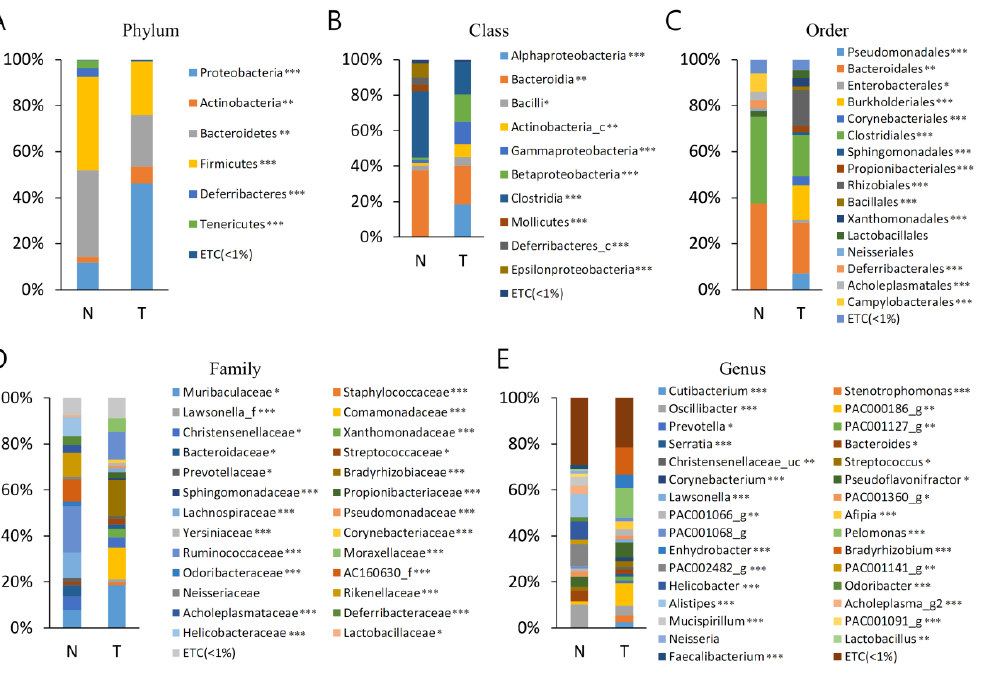
Figure 2. Averaged taxonomic composition in tumour regions (MT(T)) of prostate cancer patients and normal tissues (BPH (N)). Taxonomic relative abundance was classified at the ( A ) phylum, ( B ) class, ( C ) order, ( D ) family, and ( E ) genus levels, and relative abundances less than 1% are expressed as ETC. The Wilcoxon rank-sum test was used to analyse the significance between the two groups (*, p < 0.05; **, p < 0.01; ***, p < 0.001).